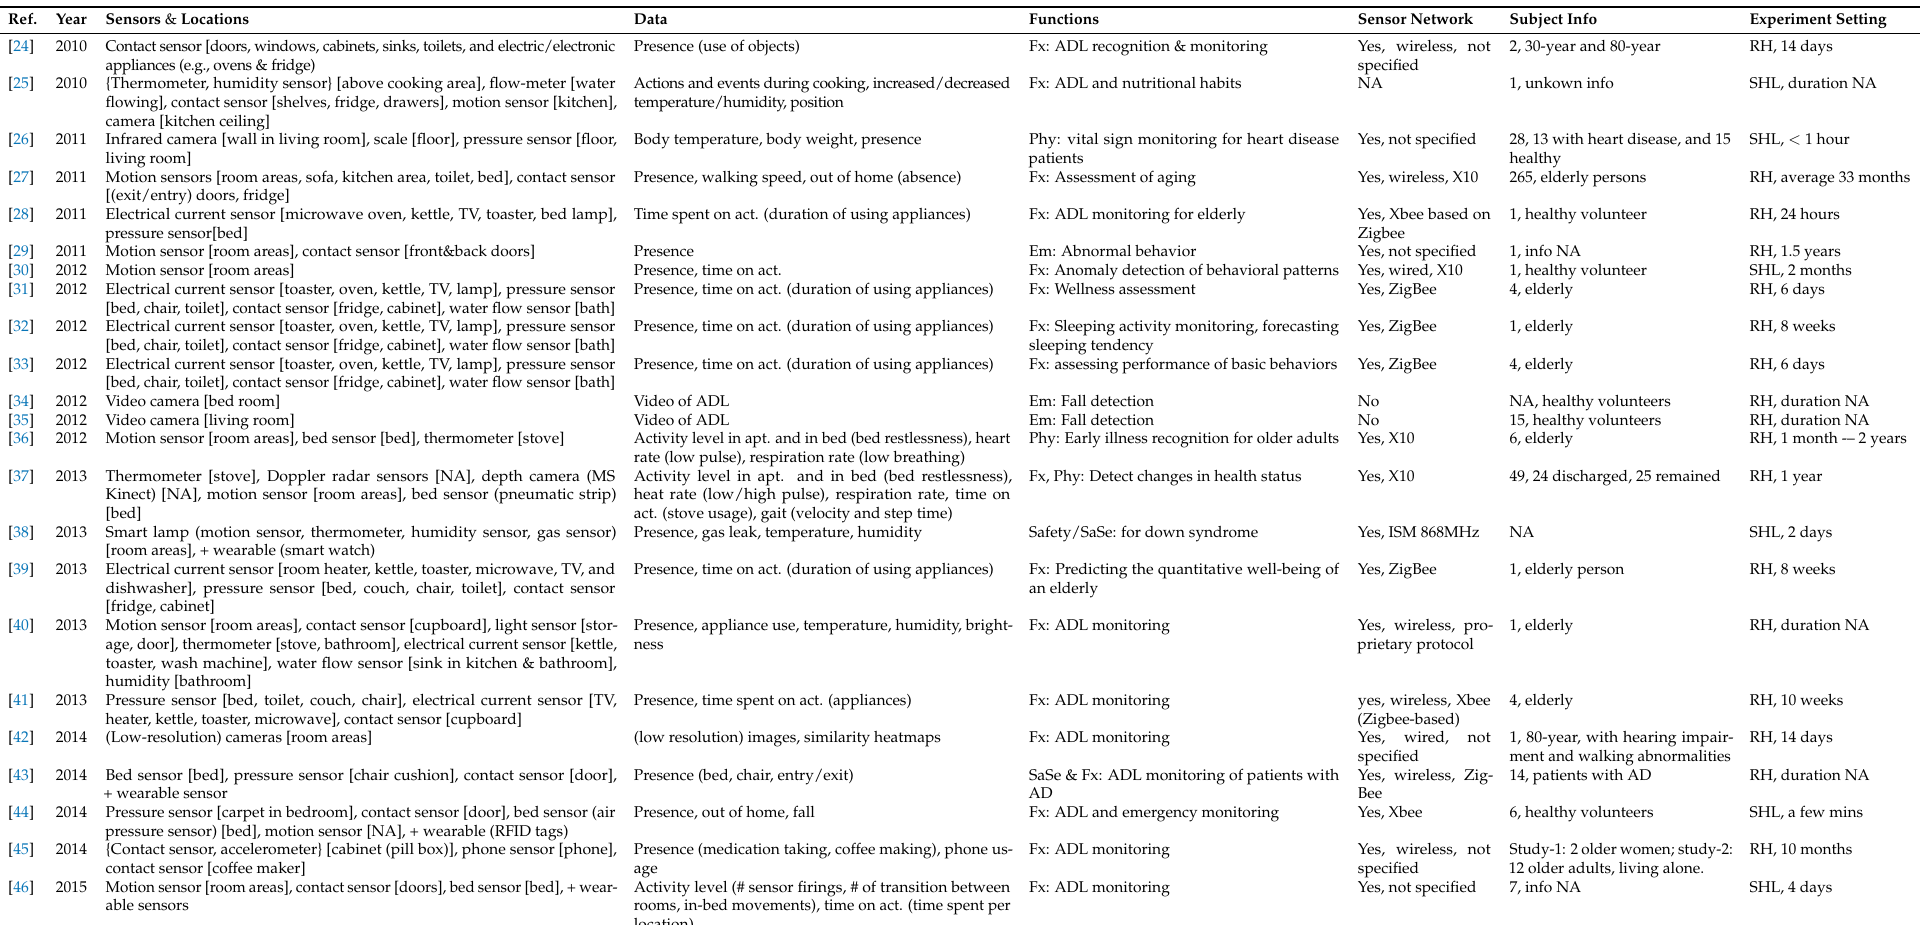
Table 1. Recent research on in-home health monitoring. NA: not available. RH: real home. SHL: smart home